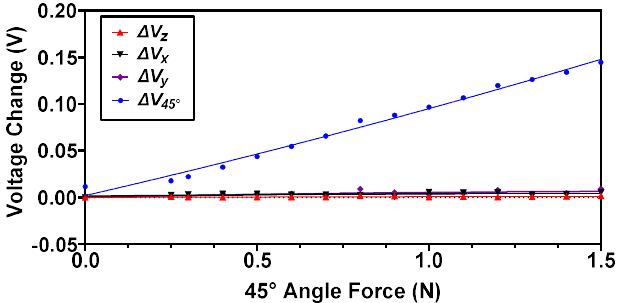
Figure 13. The output voltage response of the proposed magnetic tactile sensor for an applied force at an angle of 45°.